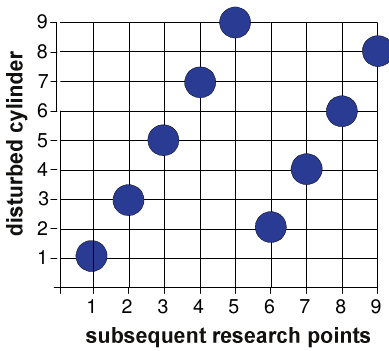
Fig. 5. Order of disturbances in mixture composition in the